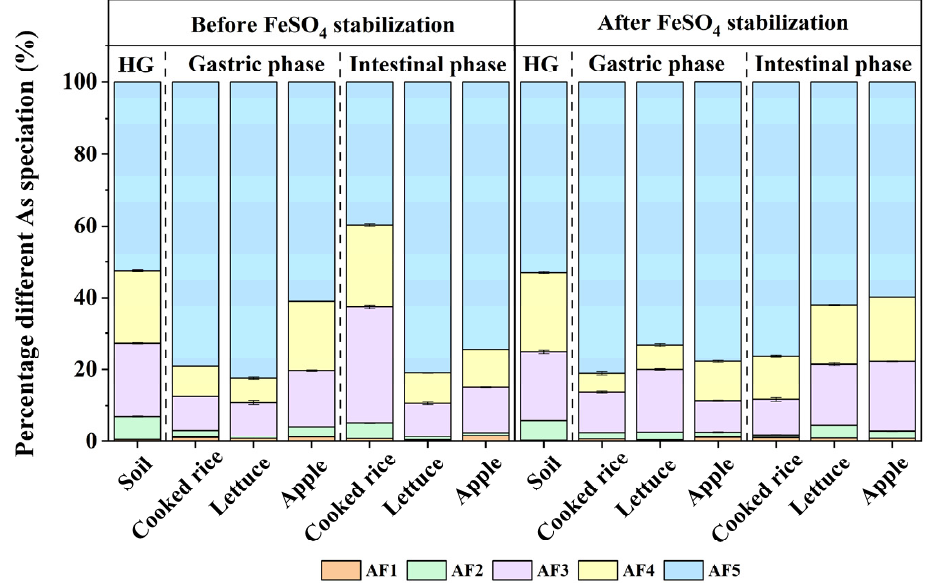
Figure 3. Transformation of As in the gastric and intestinal phases after addition of different dietary components before and after FeSO 4 stabilization. Data are presented as the mean ± standard deviation (S.D.) of the three experimental groups. ANOVA analysis reveals the statistical differences between the stabilization treatments and dietary addition groups of different As fractions. Summary of statistical information including p values is given in Table S5. HG: original soil, AF1: non–specifically bound As, AF2: specifically bound As, AF3: amorphous hydrous oxide bound As, AF4: crystalline hydrous oxide bound As, AF5: residual As.